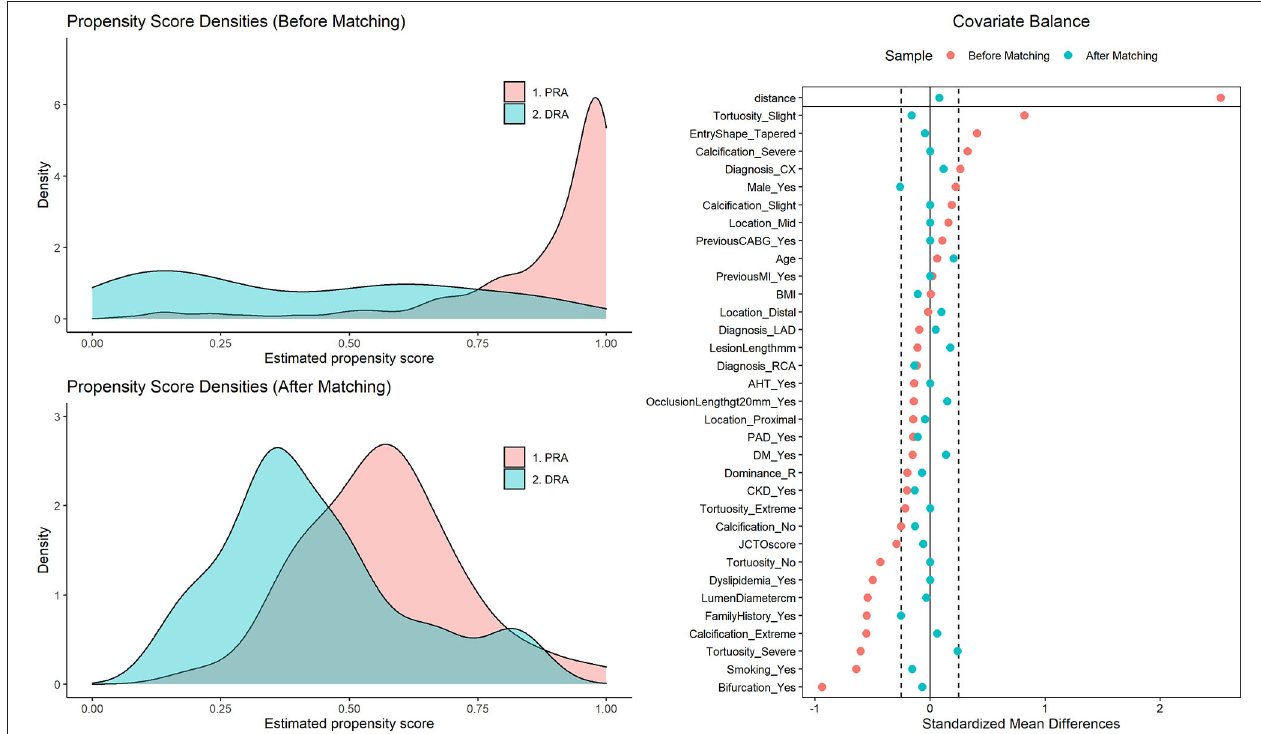
FIGURE 1 | Validation of propensity score matching. (Left) Density of propensity scores for cases in the PRA and the DRA group before and after matching. The propensity scores represent the probability for each patient of belonging to the PRA group. The overlapping area represents patients with similar propensity scores available for close matches. (Right) “Love Plot” illustrating the covariate balance created in the propensity score matched sample. The standardized mean differences comparing covariates between the PRA and DRA groups are shown both in the original sample and after propensity score matching. While there were relevant differences ( > 25%) in covariates between both groups in the original sample, after matching all are < 25%, indicating balance between cases in the PRA and DRA groups for all relevant covariates. DRA, distal radial access; PRA, proximal radial